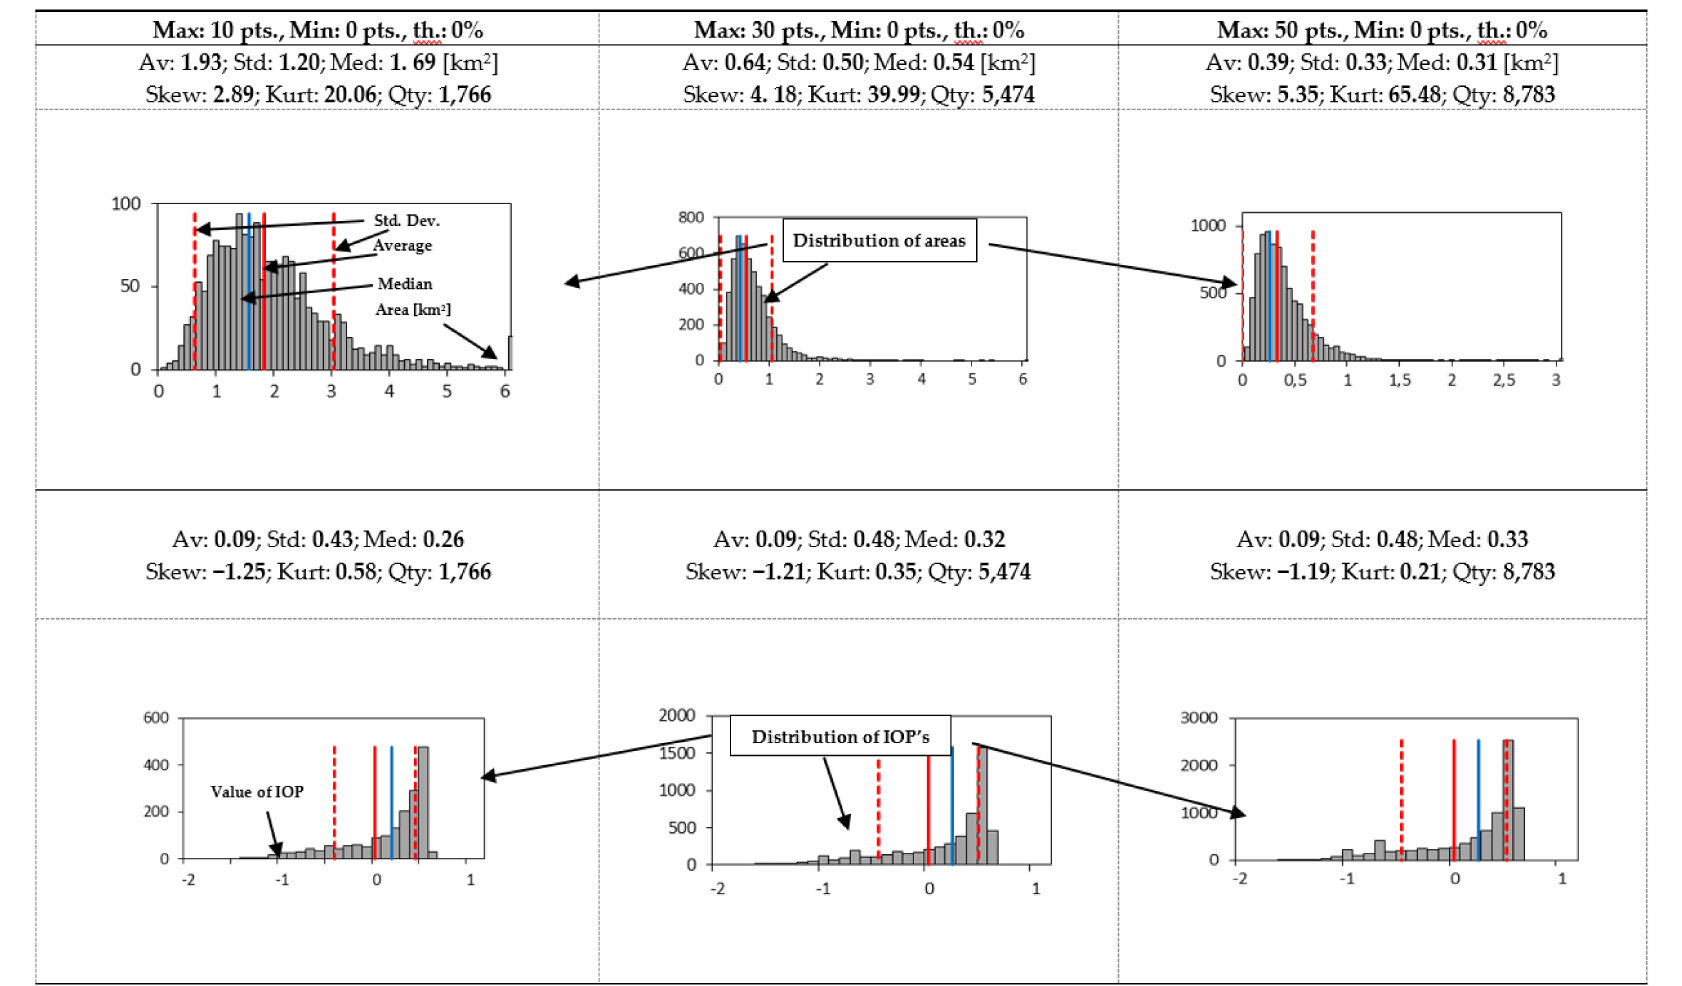
Table 5. Results for the points generated in 2 × 2 km 2